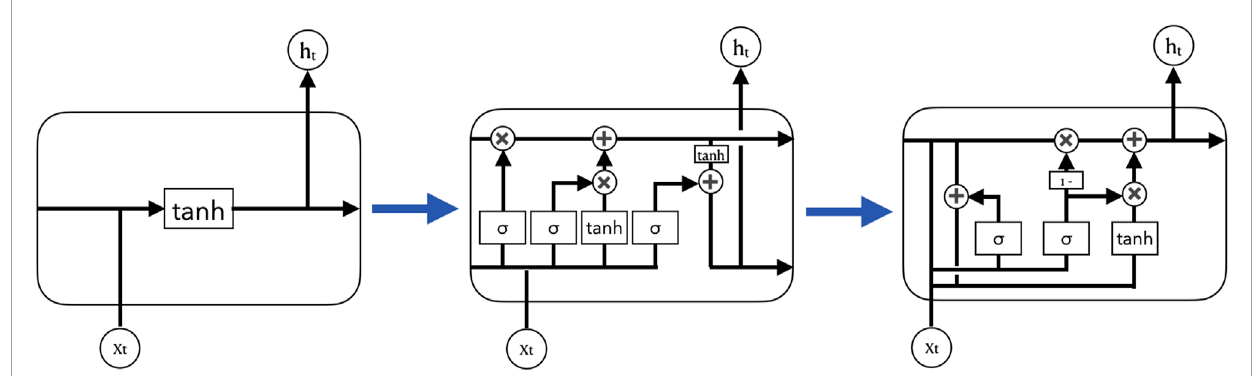
FIGURE 8 Evolution of the RNN family of models. RNN, LSTM, and GRU model structures are shown from left to right. The LSTM adds three gates (forget gate, input gate, and output gate) to the RNN, and the GRU is a variant of the LSTM that synthesizes forget and input gate into a single update